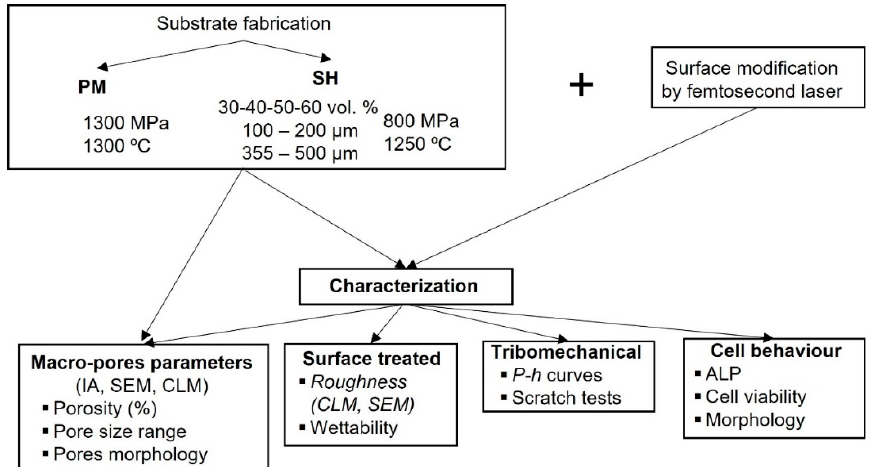
Figure 1. Scheme of the procedure followed by sample fabrication, modification, and characterization. Abbreviations: PM (Pulvimetallurgy), SH (Space Holder), IA (Image Analysis), SEM (Scanning Electron Microscopy), CLM (Confocal Laser Microscopy), ALP (Alkaline Phosphatase) and P-h (micro-indentation curve Power or Force applied vs. penetration deep)